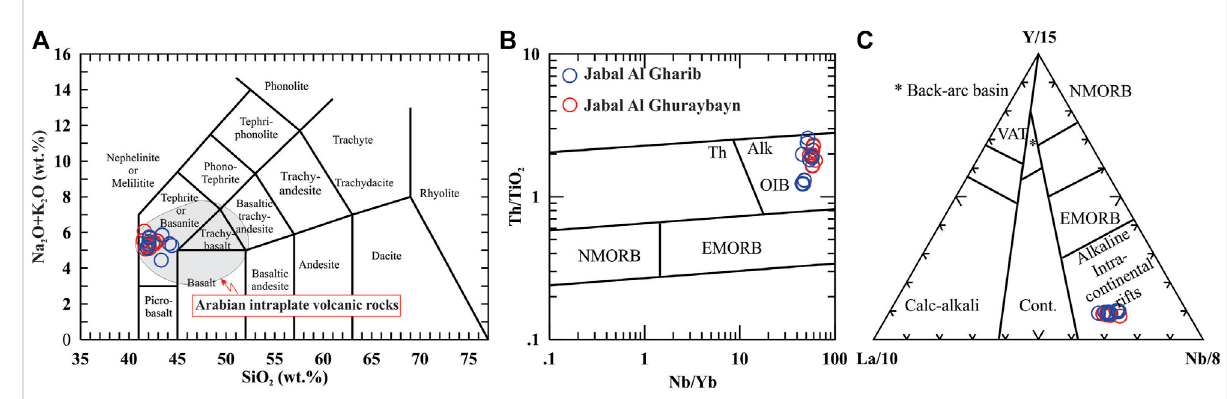
FIGURE 5 (A) Total alkalis vs. silica classi fi cation diagram (Le Maitre et al., 1989). Arabian intraplate volcanic rock fi eld is after Stein and Hofmann (1992), Krienitzetal.(2006,2007,2009),andWitteetal.(2017). (B)